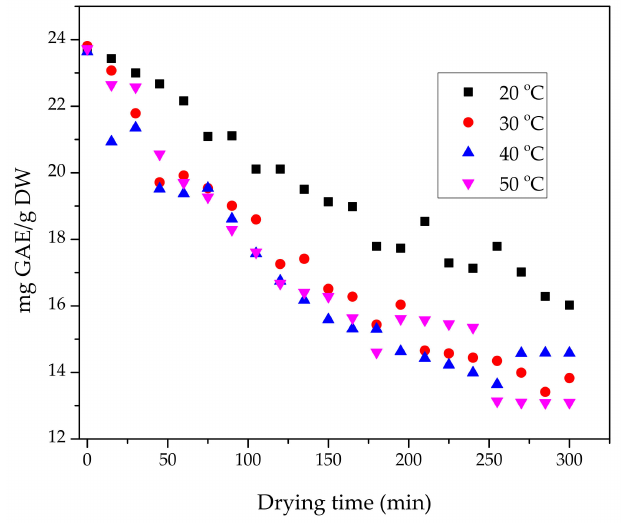
Figure 1. Decomposition of total polyphenol content under the influence of time and